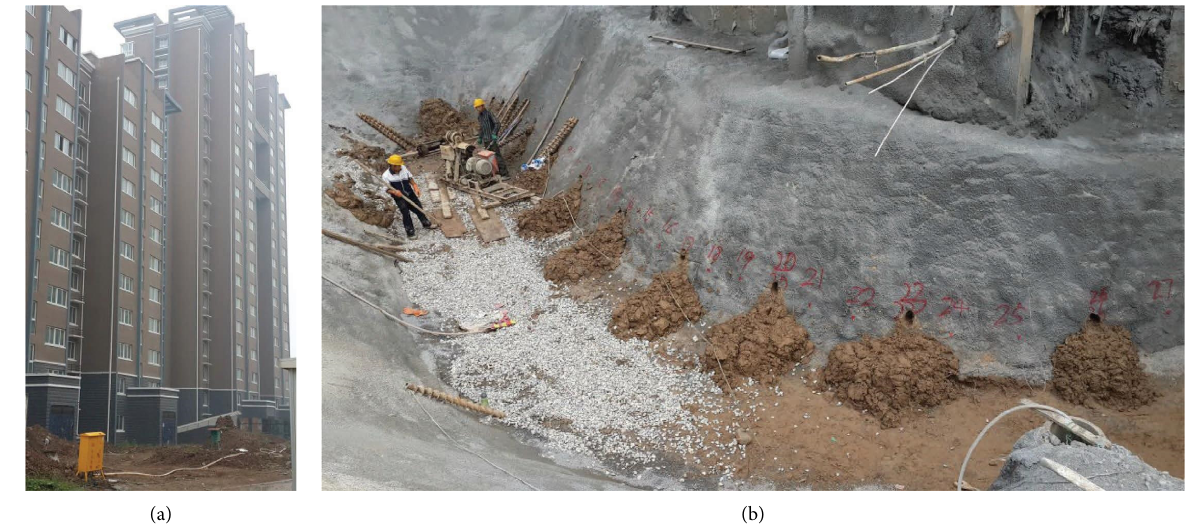
Figure 7: Underexcavation of case 1. (a) Te building. (b) Underexcavation feld.